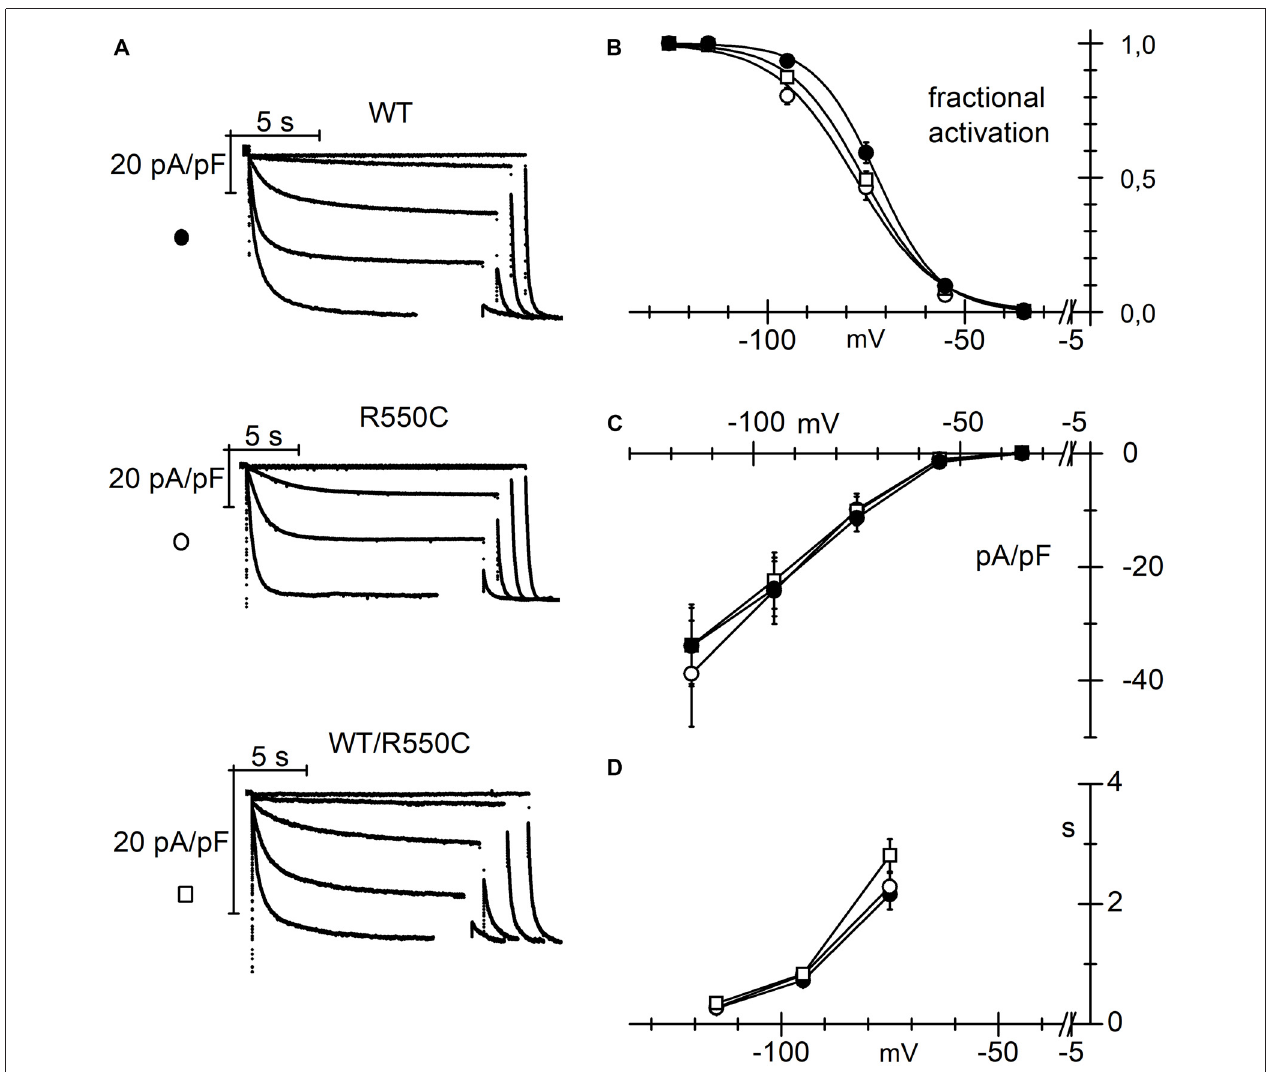
FIGURE 6 | The R550C mutation causes a negative shift of the HCN4 activation curve when expressed in cardiac myocytes. (A) Representative hHCN4 current traces recorded during a two-step activation protocol (test range − 35/ − 125 mV, hp = − 30 mV, fully activating voltage = − 125 mV) in ventricular myocytes transfected with either WT, R550C or WT/R550C hHCN4, as indicated. (B) Plot of the mean activation curves of hHCN4 currents. Mutated channels have activation curves shifted by − 3.7 to − 6 mV relative to WT. V 1 / 2 and s values from Boltzmann fitting were (mV): WT, − 72.4 ± 1.2, 7.0 ± 0.4 ( n = 21); R550C, − 78.4 ± 1.3, 9.7 ± 0.7 ( n = 15); WT/R550C, − 76.1 ± 1.0, 8.7 ± 0.6 ( n = 21). (C) I/V density curves. Current densities at − 125 mV were (pA/pF): WT, − 33.9 ± 6.7 ( n = 19); R550C, − 38.8 ± 9.3 ( n = 12); WT/R550C, − 33.8 ± 7.2 ( n = 17). (D) Mean time constants of activation. In (C,D) no significant differences were found among the three channel